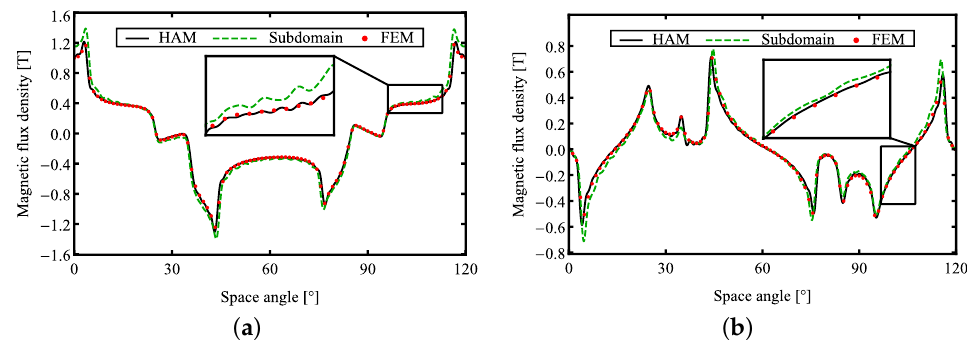
Figure 17. Comparison of the flux density at the middle of the air gap of Machine II with a current of 7 A (maximal amplitude): ( a ) radial component; ( b ) circumferential component.